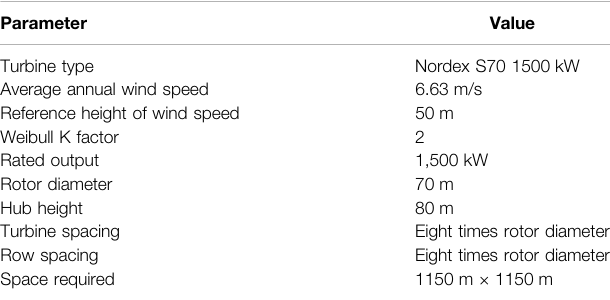
TABLE3| Windturbinemodelparameters(Shoaibetal.,2019;Shamietal.,2016; DTU Wind Energy and World Bank Group, 2018; U. D. of Energy; Lund,